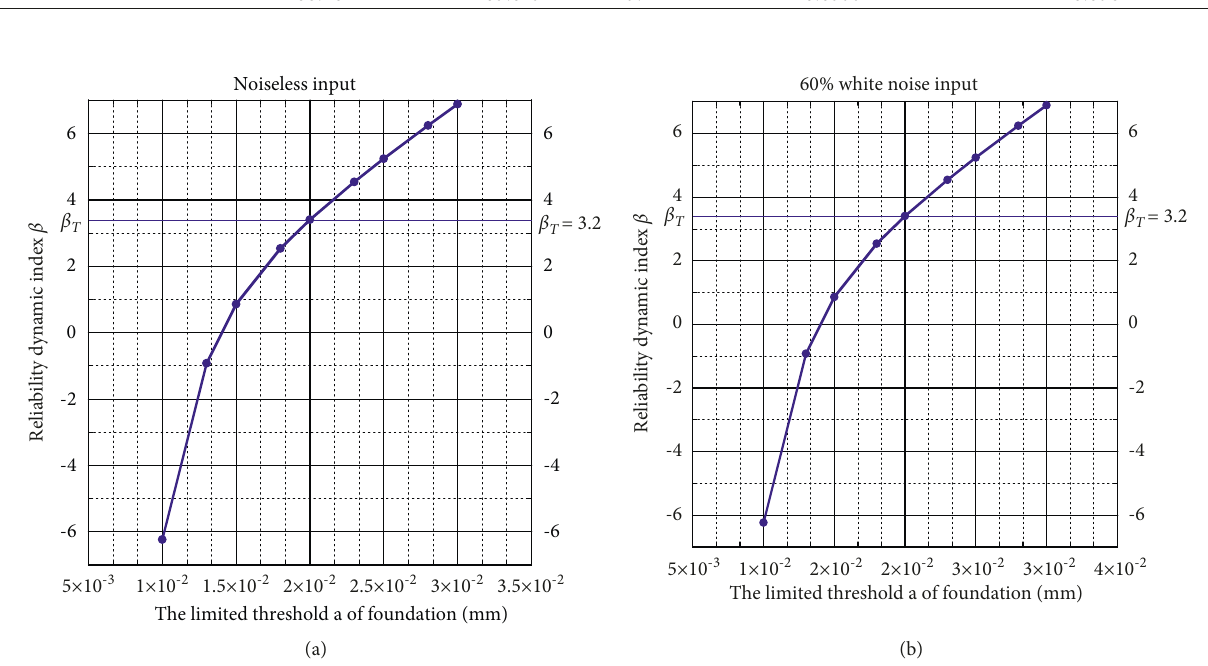
Figure 9: Relationship between the dynamic reliability β and limited threshold a for foundation of stone cutting machine: (a) noiseless identification; (b) 60% white noise excitation identification.